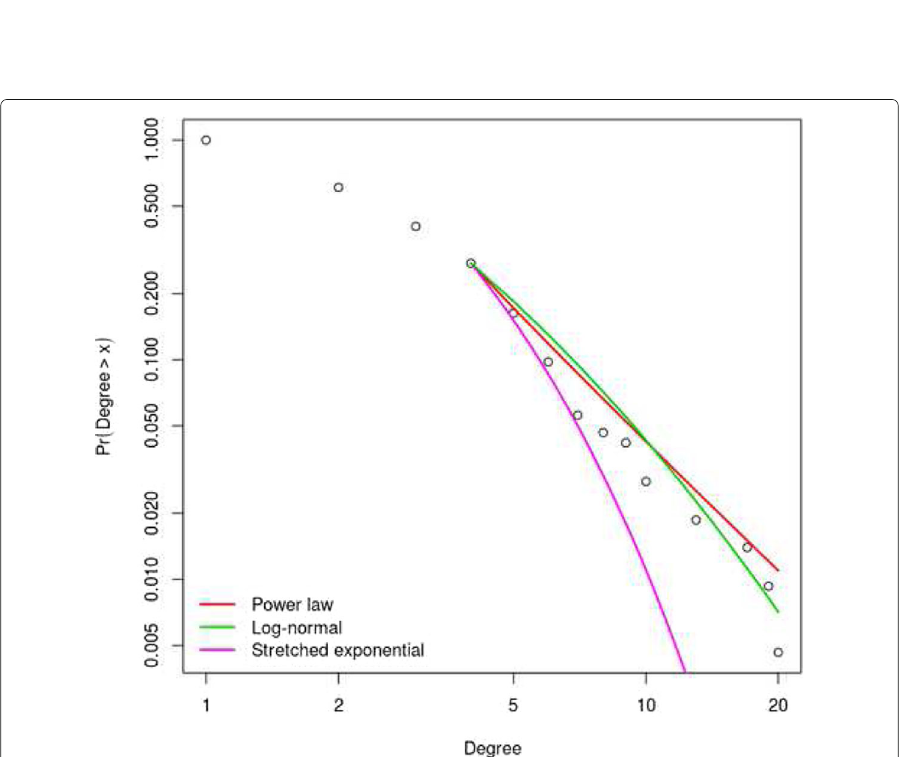
Fig. 5 Degree distribution for threshold 1273 (6%). We show the fitted complementary c.d.f.s for a power law, a log-normal and stretched exponential (Weibull) distributions. We estimated x min = 4 using the method of Clauset et al. (2009). For this threshold, the power law provides the best fit to data (see